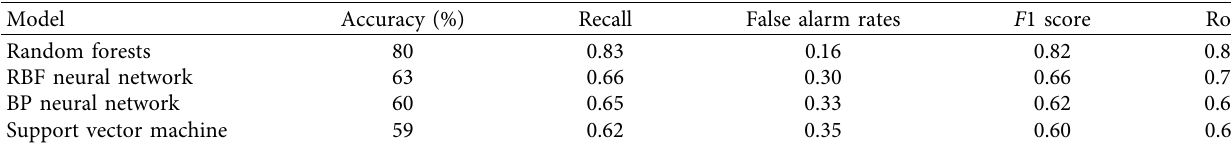
Figure 4: Importance of accident Table 3: Prediction performance of each model.